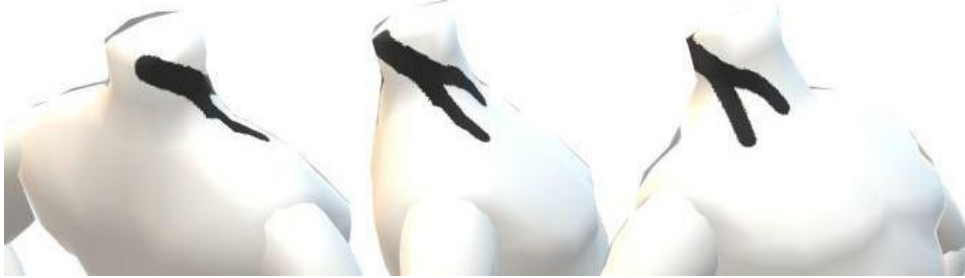
Figure 1. 3D graphical representation of Kinesio-tape application (right